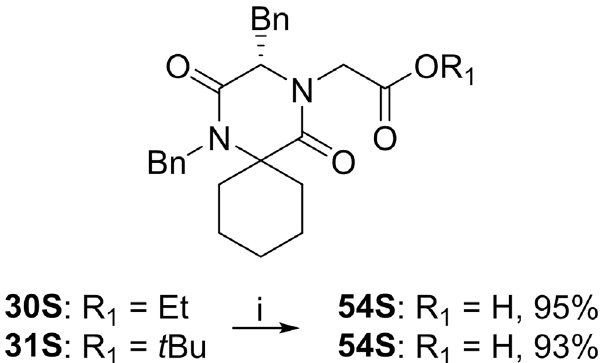
Fig 15. Ester hydrolysis of 30S and 31S. Reagents and reaction conditions: i) Conc. HCl (aq.) for R 1 = Et, 70°C o.n. For R 1 = t Bu, r.t. o.n.